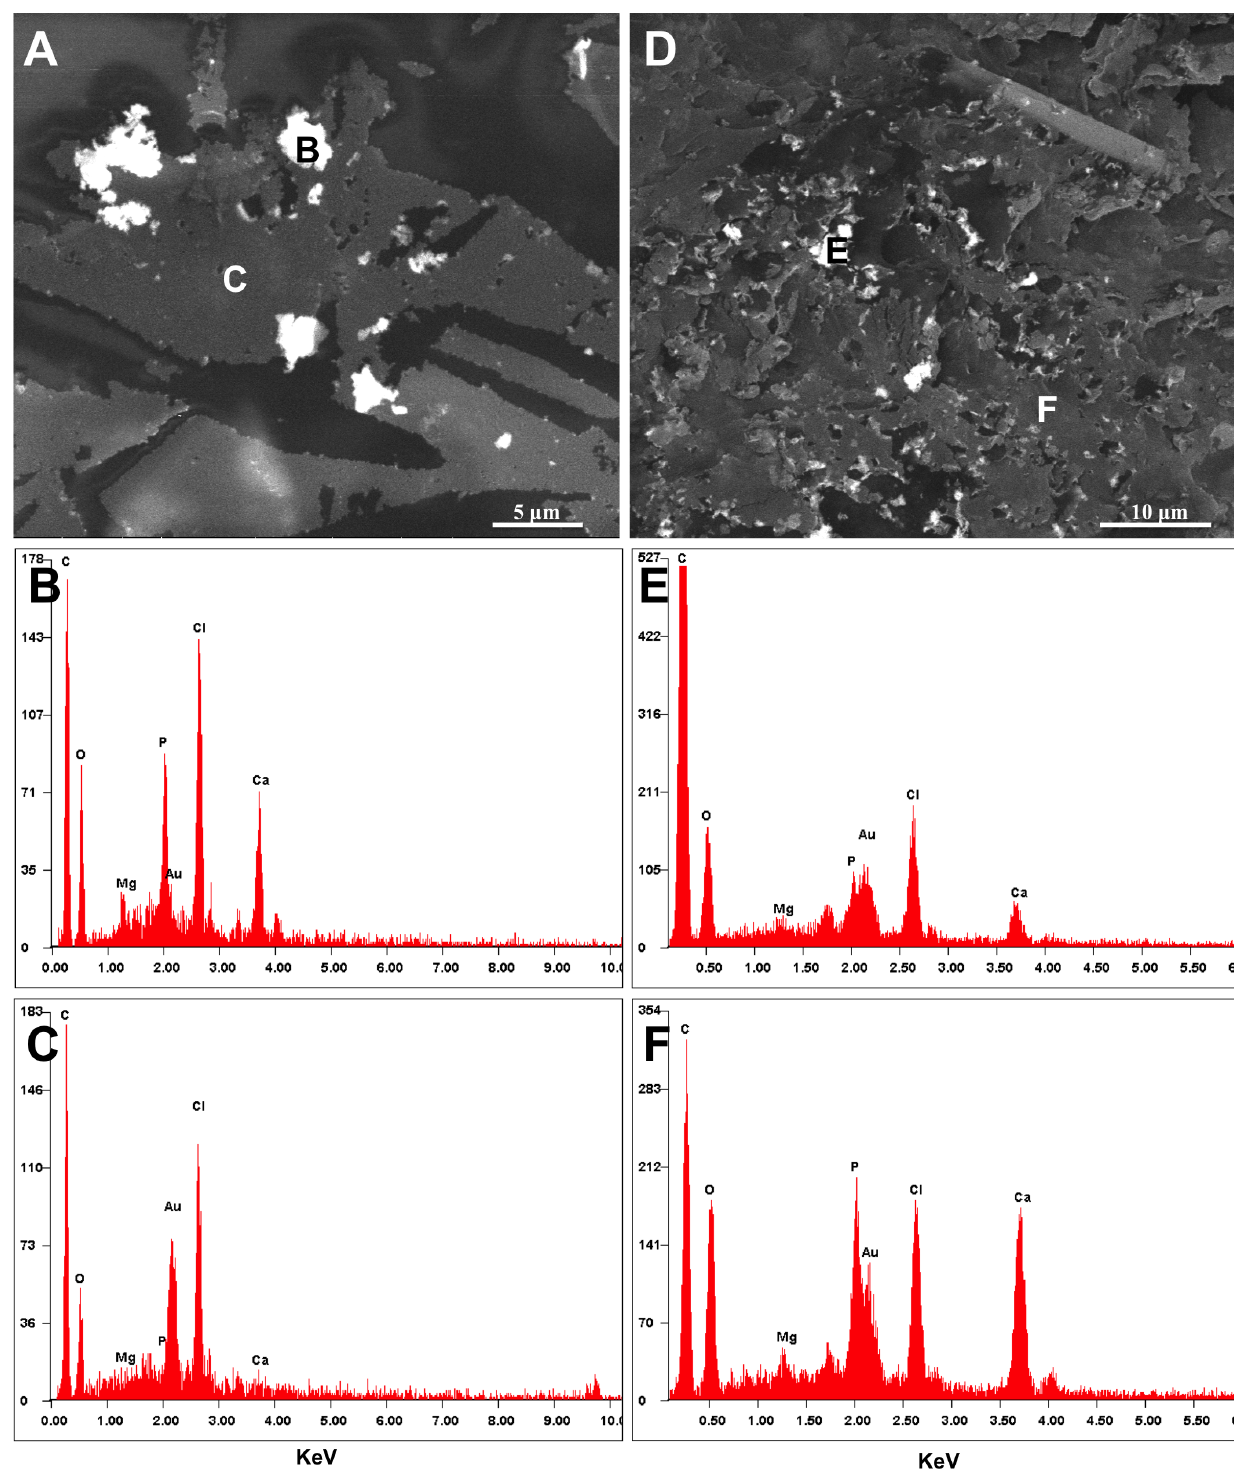
Figure 11. Backscatter electron image and EDS analysis by SEM of samples recovered after 15 days, also shown in Figure 9. (A) Sample recovered from sterile DSMZ medium, and (B) EDS analysis of its precipitate. (C) EDS analysis of the embedding epoxy matrix. (D) Sample recovered after 15 days of C. hydrogenoformans growth in the DSMZ medium, and (E) EDS analysis of its solid precipitate, (F) EDS analysis of its embedding epoxy matrix showing that Ca and P are present.